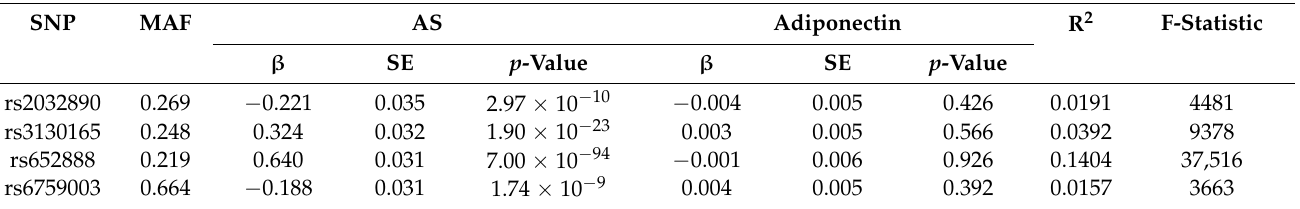
Table 3. Detailed statistics of selected instrumental variables for ankylosing spondylitis and their relationship with circulating adiponectin levels.